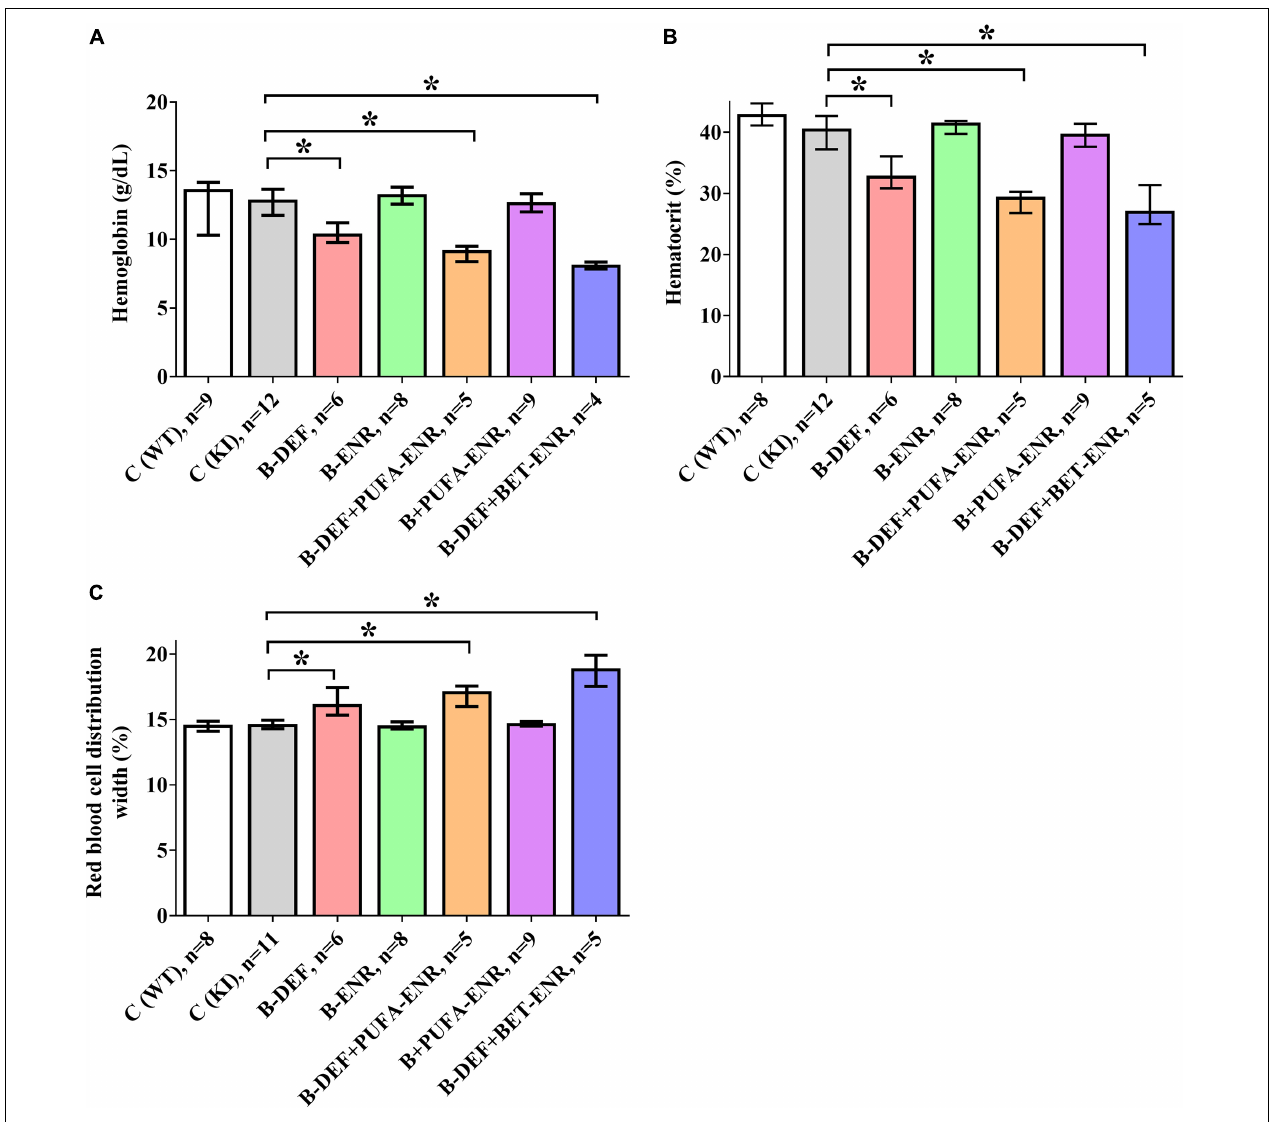
FIGURE 5 | Hematological parameters in whole blood at the age of 67–68 weeks; median ± IQR; outliers beyond 3-fold IQR removed; p < 0.05 (Mann-Whitney- U -test) considered statistically significant (*); (A) hemoglobin concentration; (B) : hematocrit; (C) red blood cell distribution width coefficient of